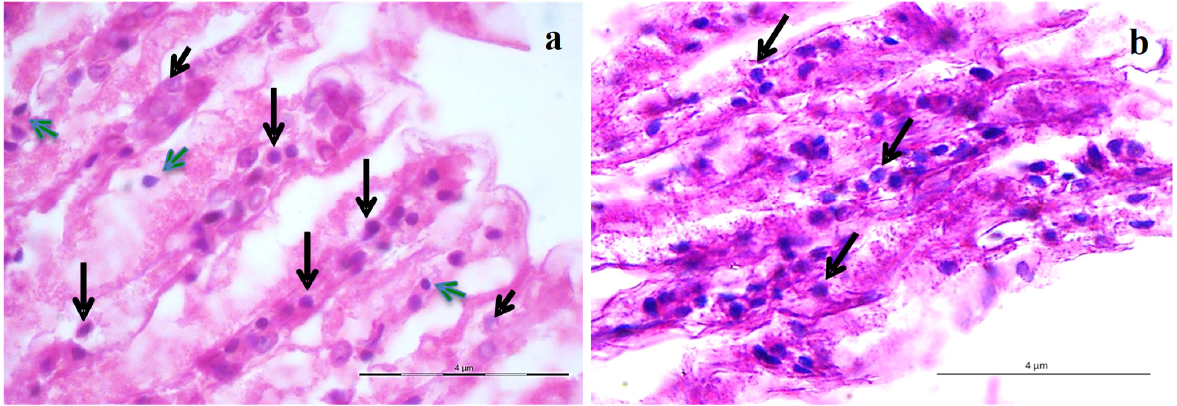
Figure 4. Histopathology of the shrimp ( Penaeus monodon ) gill sections. ( a ). Gill sections showing intra-nuclear eosinophilic cowdry type A inclusion bodies (long black arrow) pathognomonic to IHHNV and eosinophilic to basophilic inclusion bodies suggestive of WSSV infection (short green arrow) and normal cells (short black arrow). ( b ). Gill sections showing WSSV characteristic more basophilic intra-nuclear inclusion bodies (black arrow). Scale bar 4 µm.